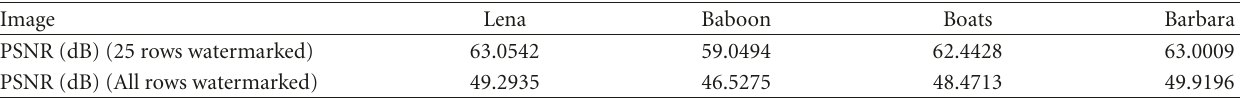
Table 1: PSNR Values of the watermarked images. Image Lena Baboon Boats